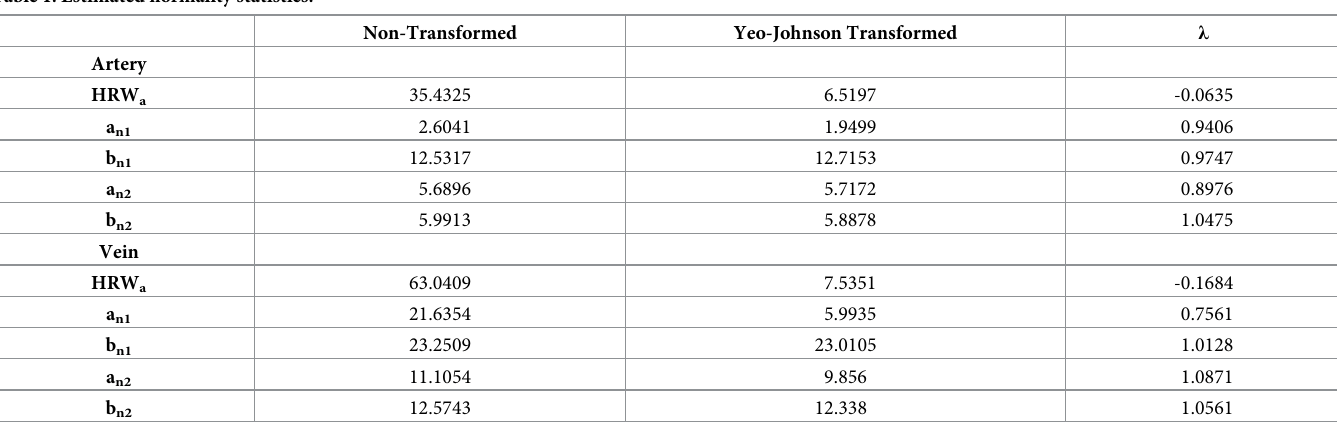
Table 1. Estimated normality